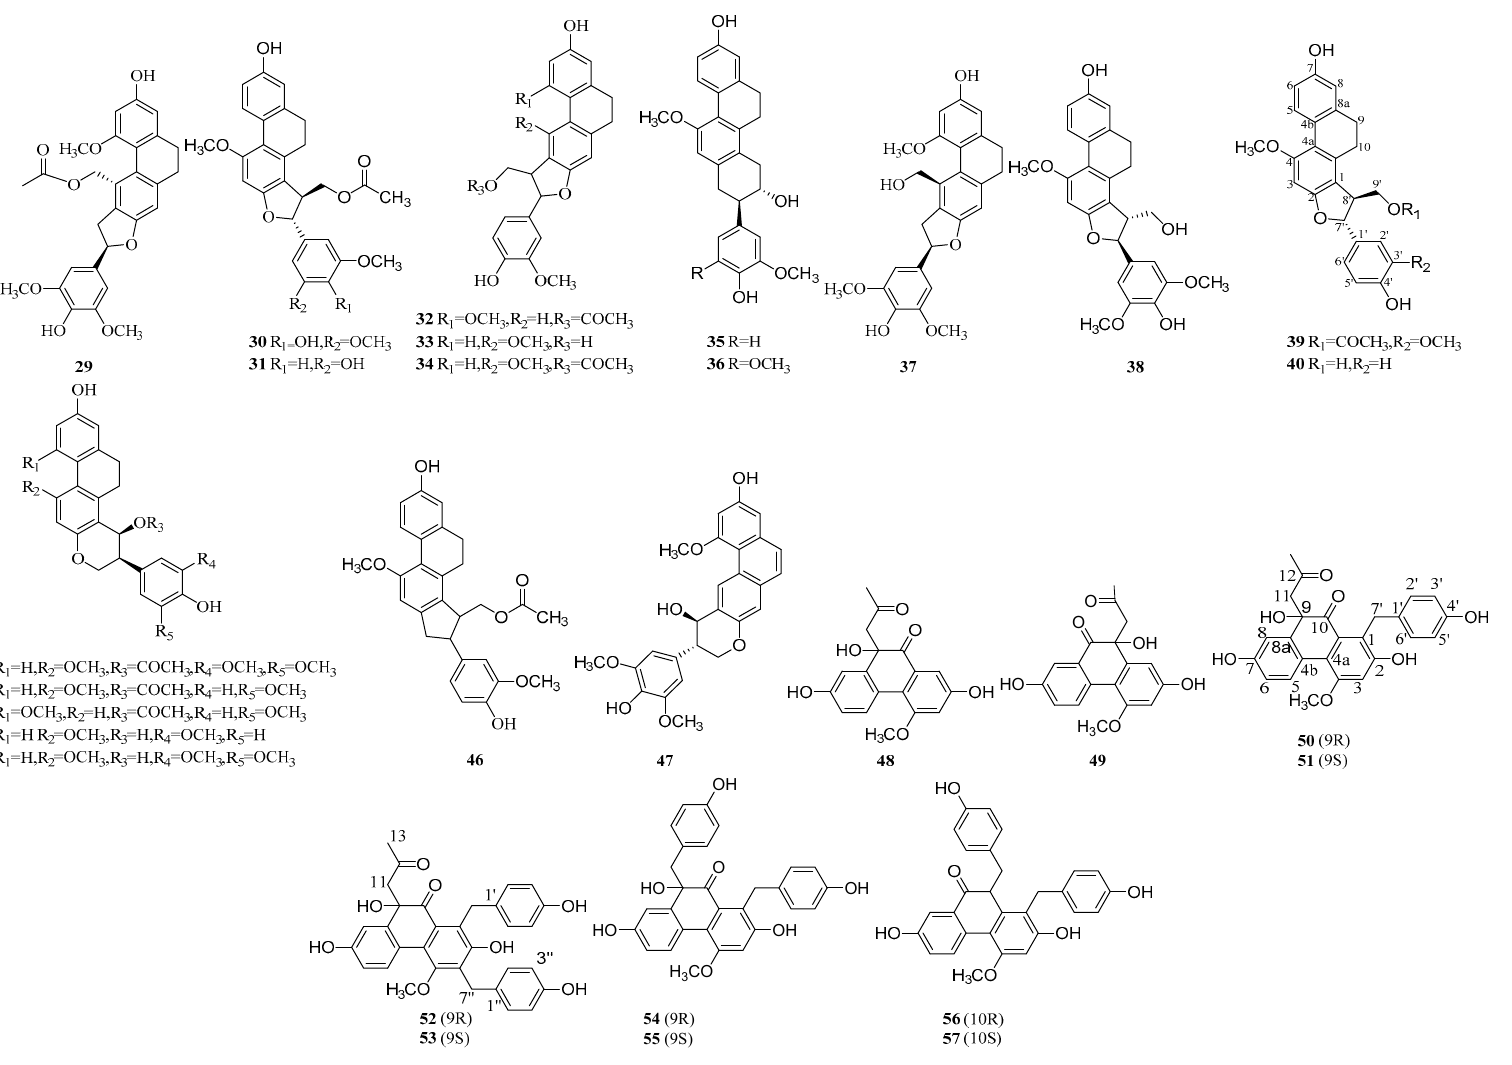
Figure 1. The structures of Phenanthrenes.